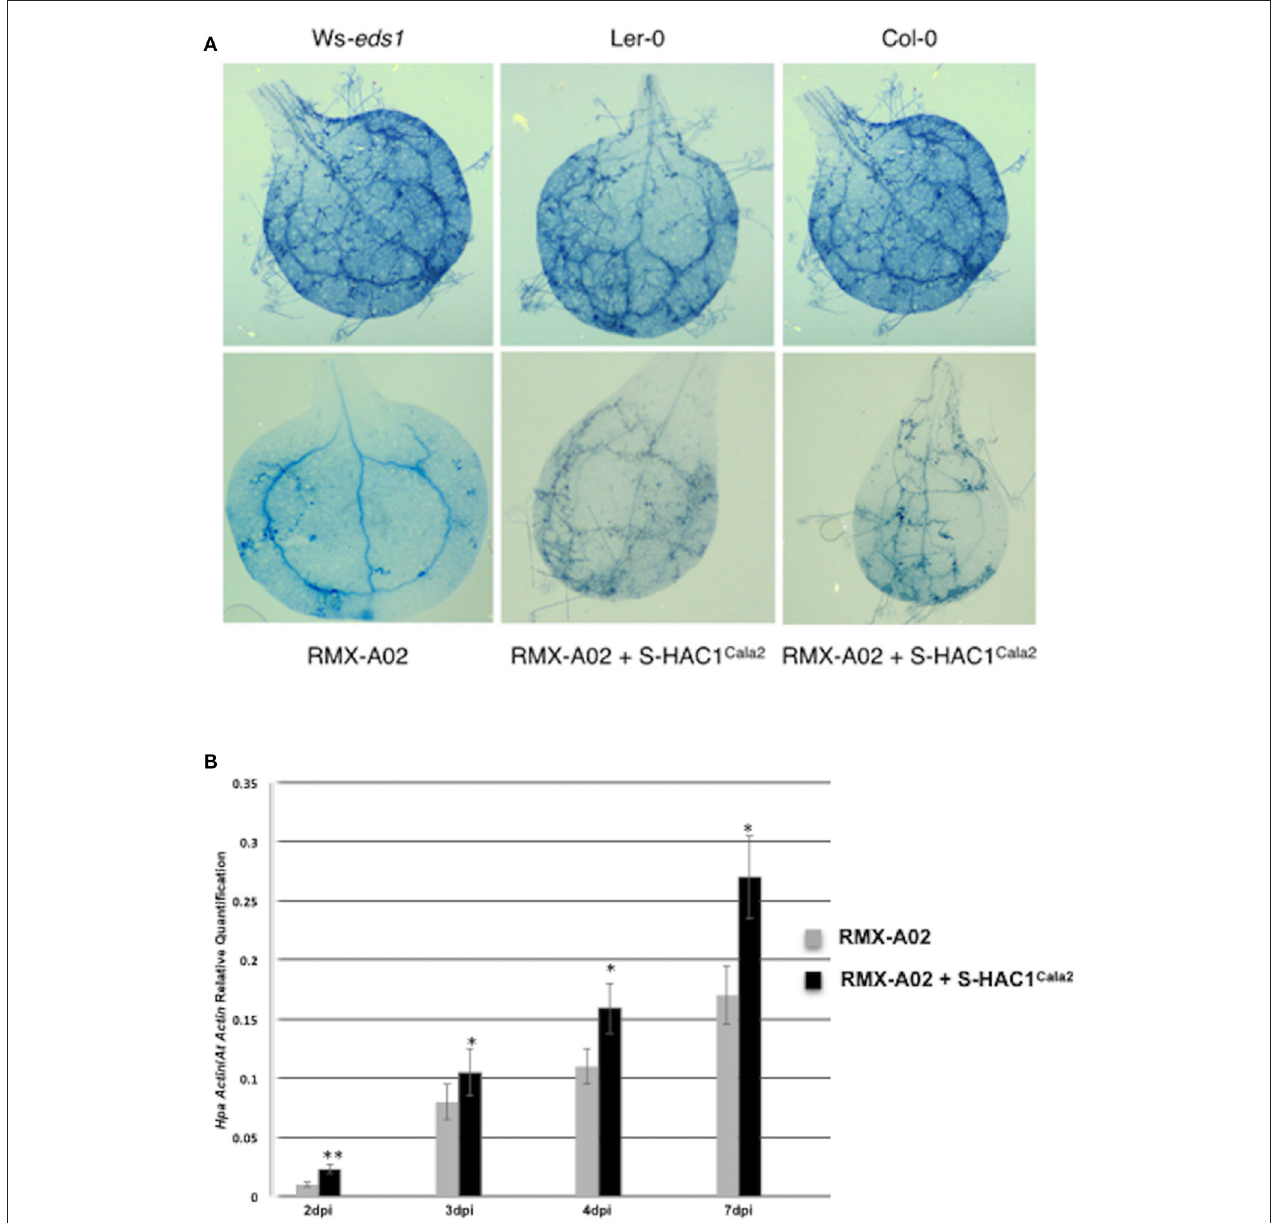
FIGURE 5 | Overexpression of S - HAC1 Cala2 in RMX-A02 displays altered phenotype and biomass production. The S-HAC1 Cala2 gene was cloned under a 35S promoter and introduced to RMX-A02 plants. Homozygous T 3 lines were challenged with avirulent F 2 isolate, CaNo F 2 110. (A) , wild-type and transgenic seedlings inoculated with CaNo F 2 110 and stained with trypan blue 7 days post inoculation (dpi); (B) , pathogen biomass production in transgenic and non-transgenic RMX-A02. Relative abundance of Hpa-Actin ( Hpa-807716 ) to Arabidopsis At5g46630 gene was calculated from infected plant materials 2, 3, 4, and 7 dpi. Three samples were included for each analysis and the experiments were repeated three times. The increase in pathogen biomass in RMX-AO2 + S-HAC1 Cala2 compared with that in the RMX-A02 control was statistically significant (* P < 0.05, ** P < 0.01; Student’s t- test).